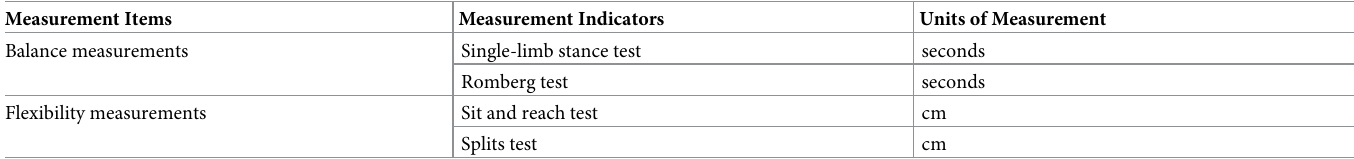
Table 2. Measures of balance and